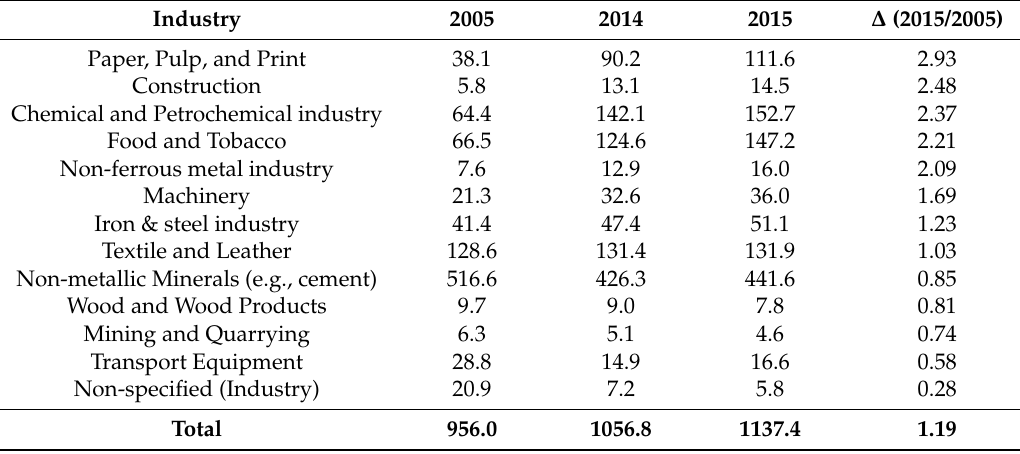
Table 3. Natural gas consumption (ktoe) by the Portuguese industry (data taken from [27]).